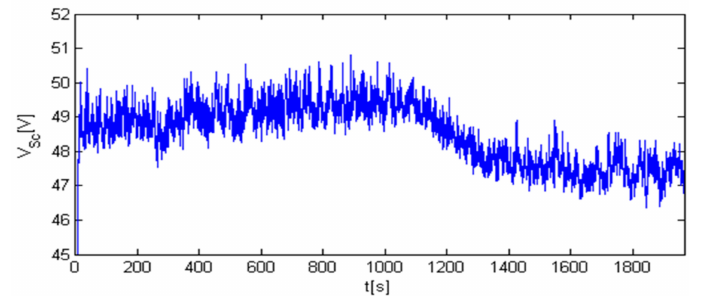
Figure 34. Supercapacitor module terminal